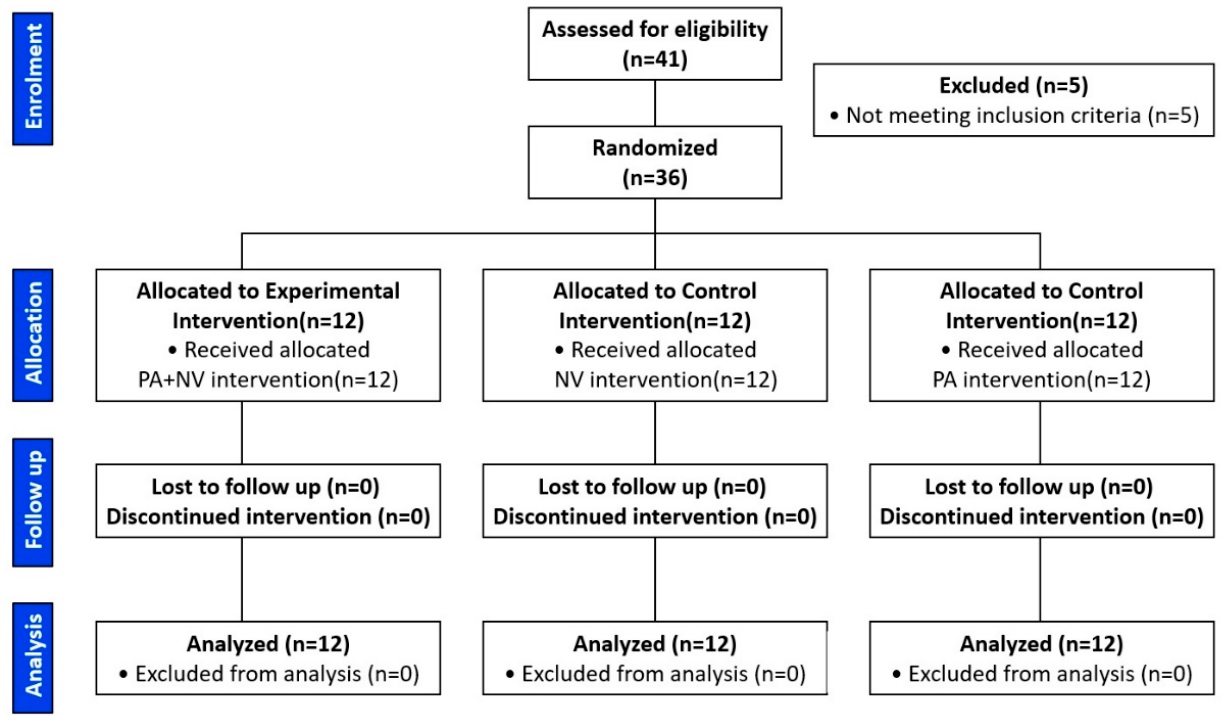
Figure 1. Flow chart of the participant selection process in this study.